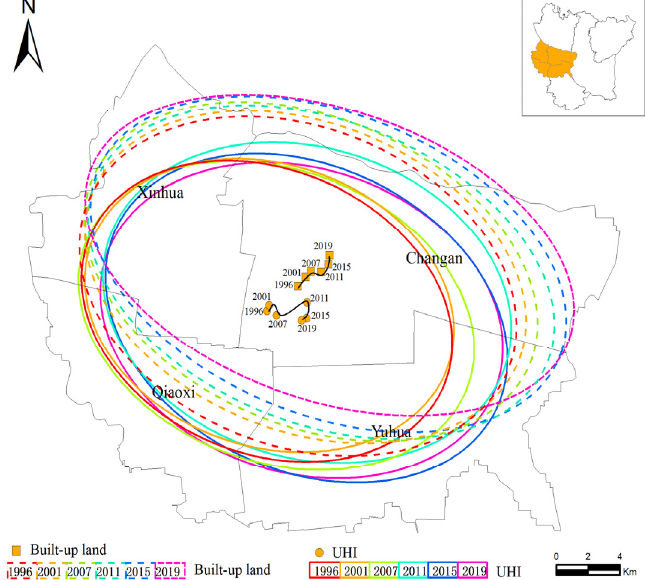
Figure 7. Evolution of center points and standard deviation ellipse (SDE) of built-up land of the study area from 1996 to 2019.